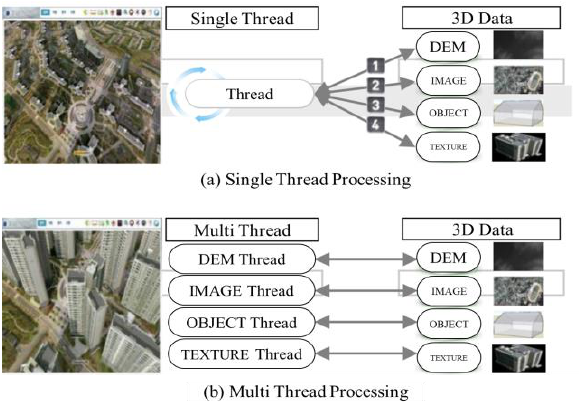
Figure 4. Comparison of Single Thread Processing with Multi Thread Processing